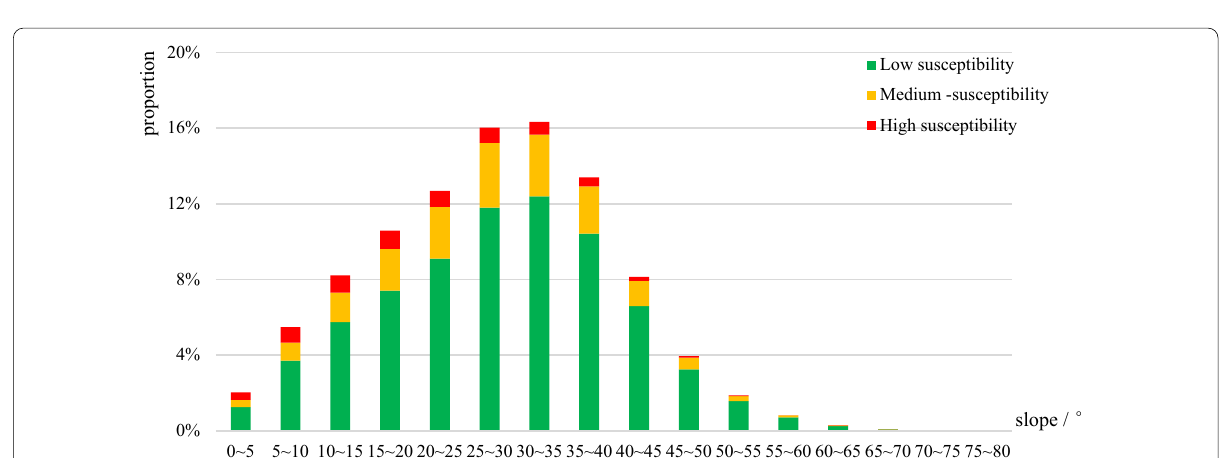
Fig. 11 Relationship between debris flow susceptibility and